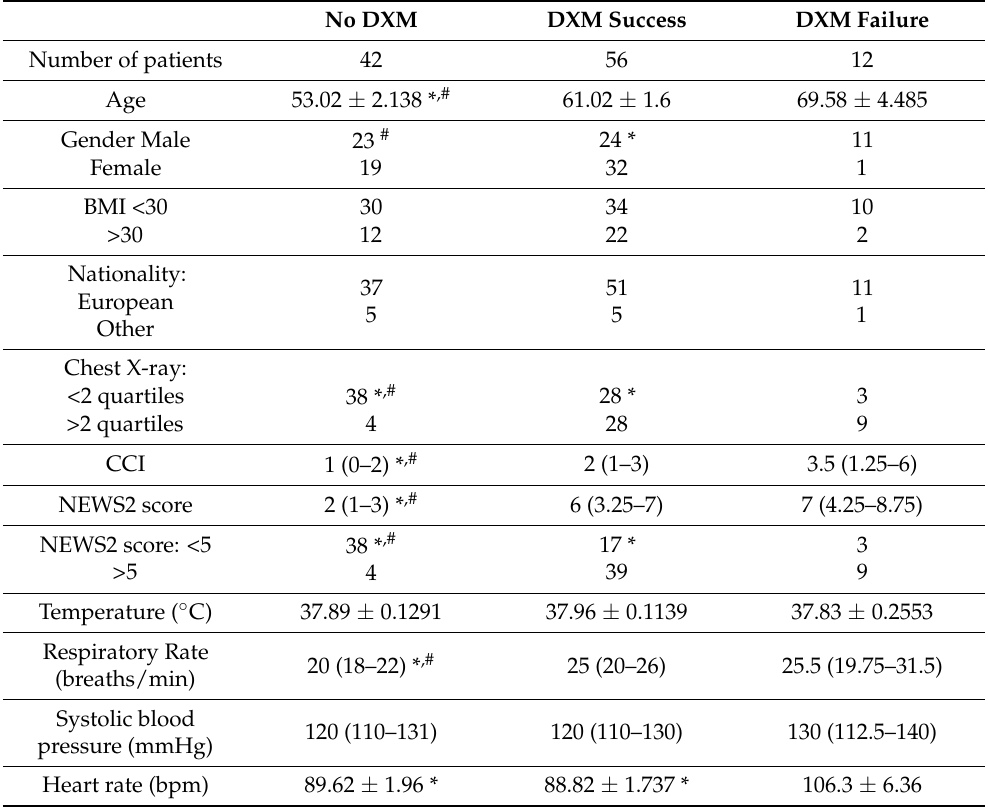
Table 1. Clinical and epidemiological characteristics of patients on